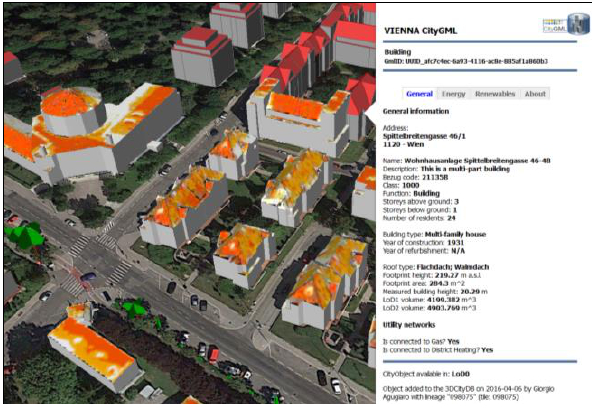
Figure 2. Example of visualisation of the 3D city model in Google Earth: thematic data for each building can be accessed in the balloon